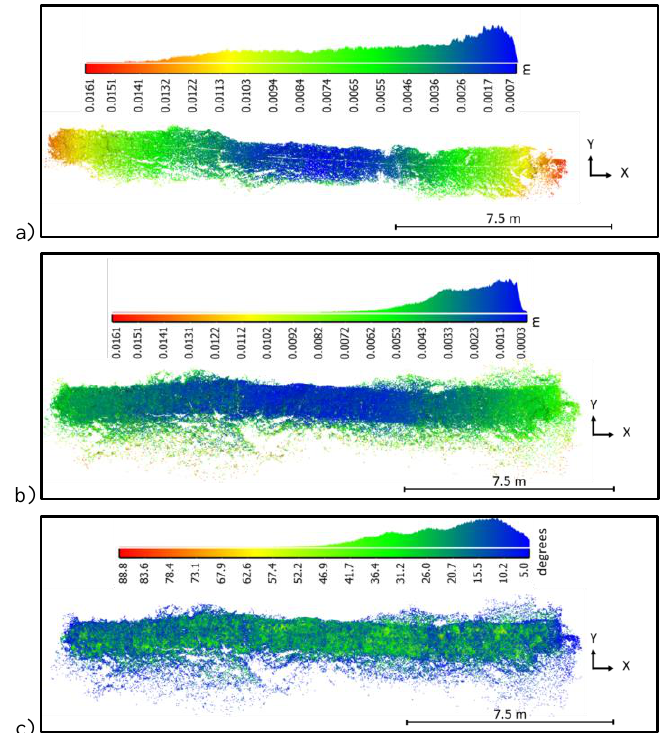
Figure 4. 3D tie points colored according to: a) the precision vector length (in meters) for T1-2017 with only nadir looking images, b) the precision vector length (in meters) for T1-2017 with nadir and oblique looking images; c) the intersection angle (in degrees) for T1-2017 with nadir and oblique looking images.